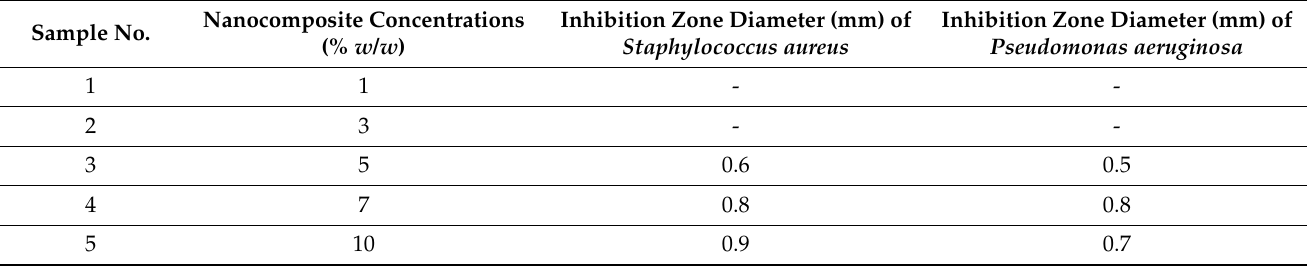
Table 3. Inhibition zone of antibacterial test of the BaSO 4 nanocomposite. Sample